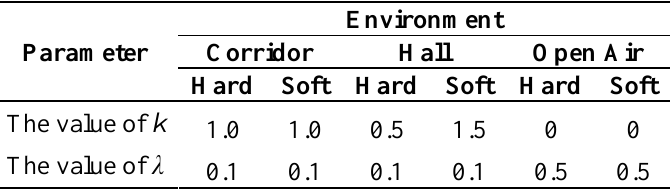
Table 6. The experimental parameters and